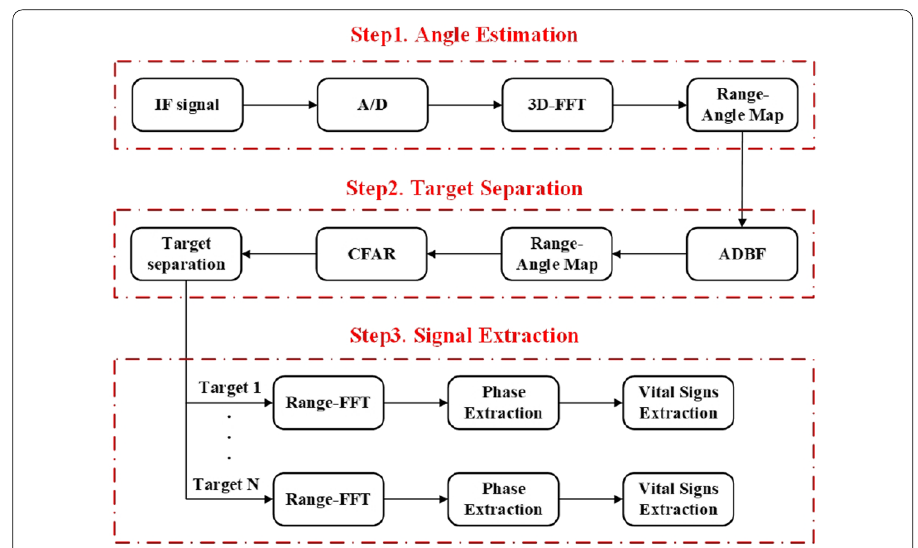
Fig. 1 Multi-human targets vital signal